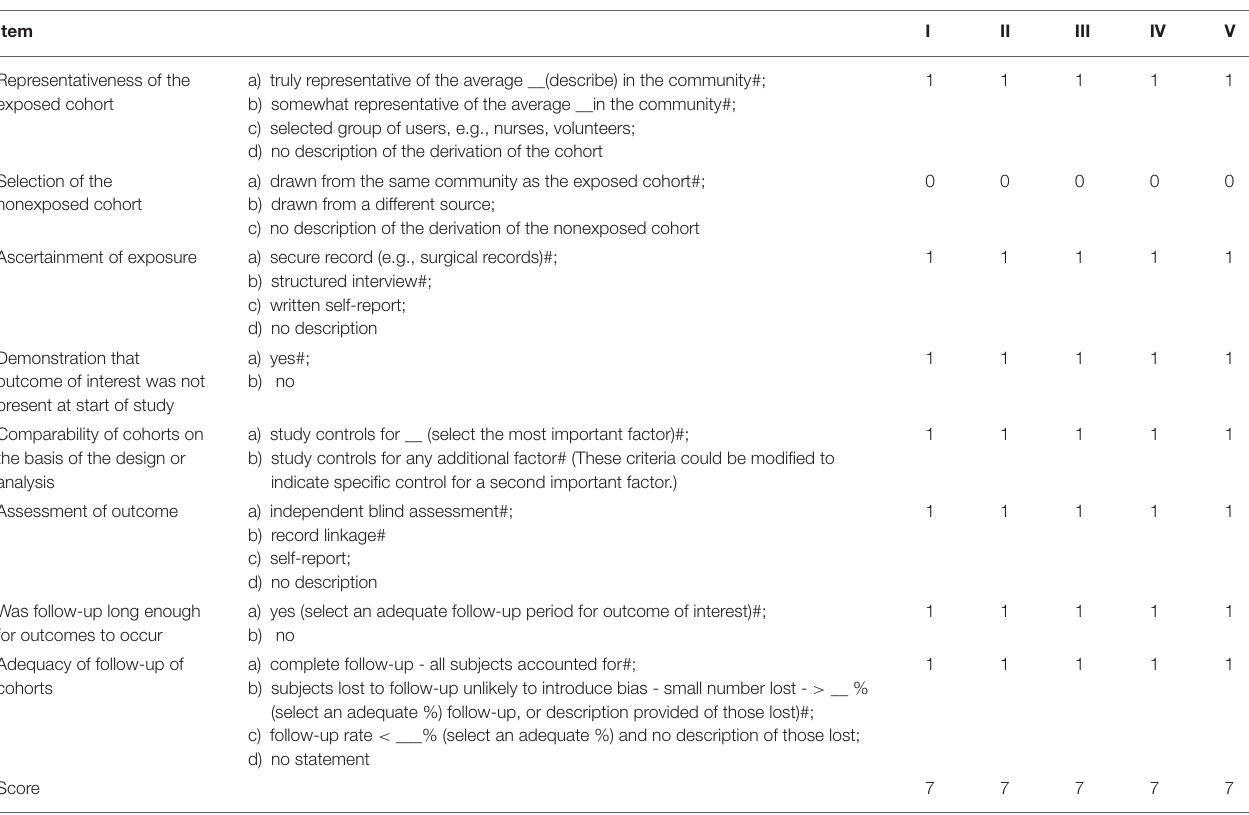
TABLE 2 | Newcastle-Ottawa Scale (cohort) for five studies a included in this